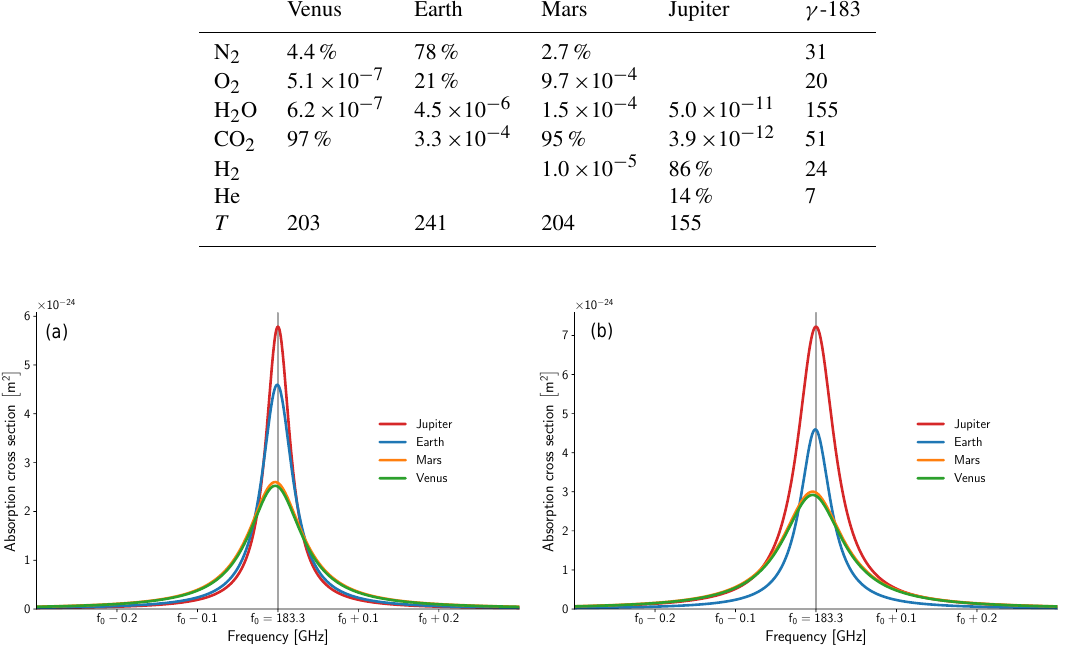
Figure 2. Absorption cross section of the 183GHz water vapor line at 700Pa for the different atmospheric compositions listed in Table 2, assuming a Voigt line shape function: (a) using the Earth atmosphere temperature for all four cases, so that differences are only due to the different pressure broadening coefficients; (b) taking also the temperature from the different planet scenarios, which affects the line strength, corresponding to the integral under the